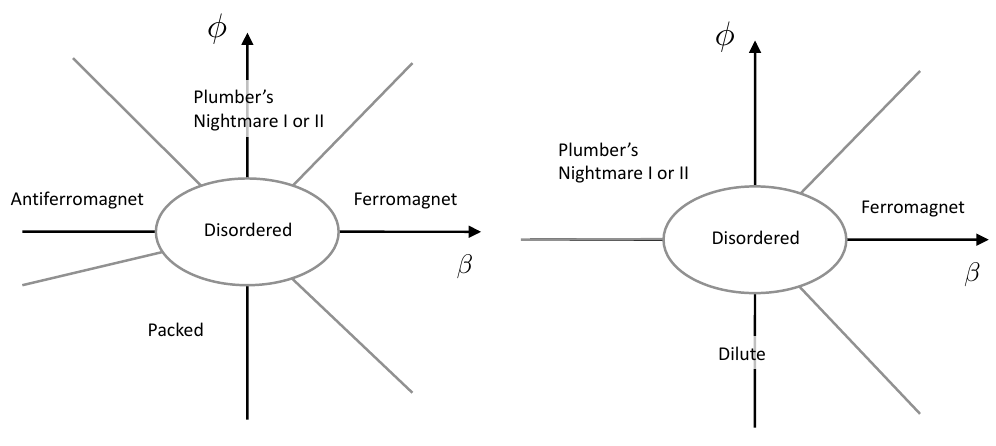
Figure 7: “Mean-field” phase diagrams (arising from minimizing classical Hamil- tonian) for branch-point vertex resolution ( left ) and no-touching vertex resolution ( right ). Note that as the two plumber’s nightmare phases have the same A and χ this energetic analysis cannot distinguish between them. At small β , φ we expect to find a disordered